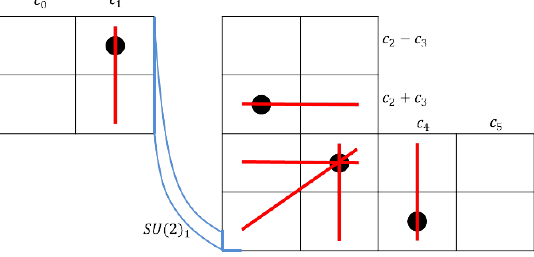
Figure 10 . The tetris diagram of the SU(2) 3 generalized quiver. The coupling of the hypermul- tiplets to SU(2) 1 is represented by the curved blue lines. The charges of the hypermultiplets are written on the diagram. The vacuum presented here is the fully Higgsed vacuum S-dual to the fully Higgsed vacuum of the linear quiver studied